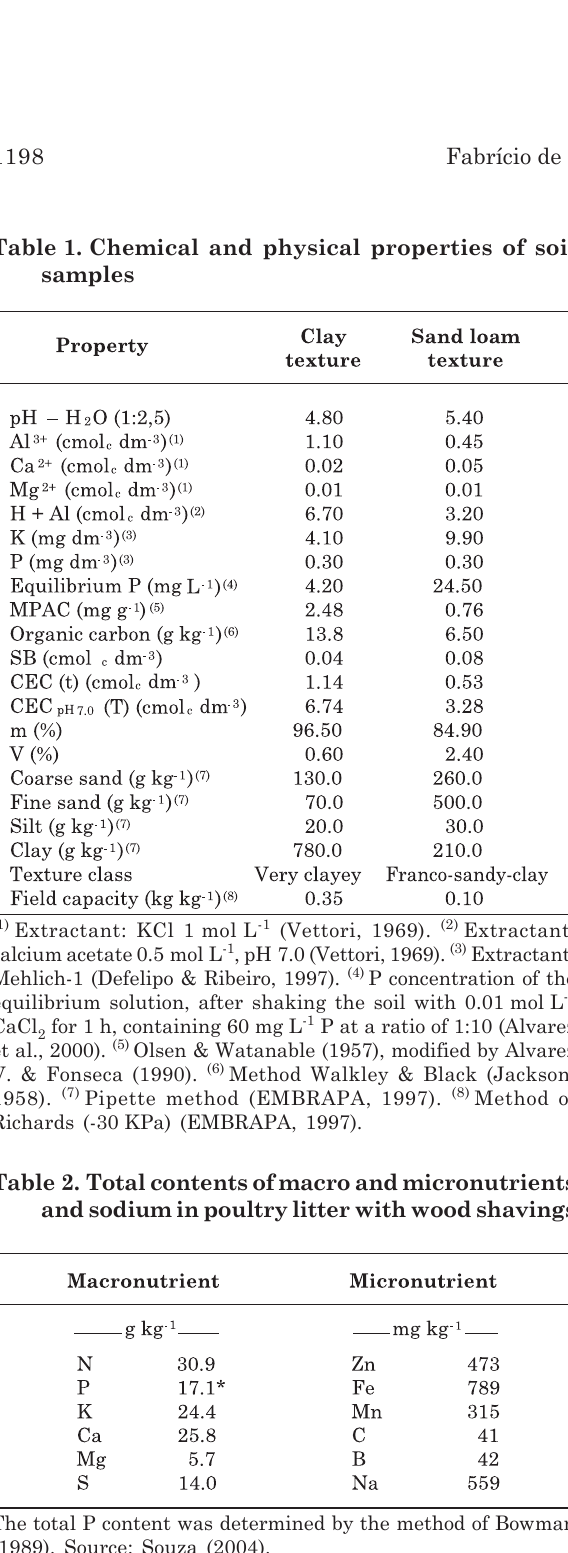
The total P content was determined by the method of Bowman (1989). Source: Souza (2004).